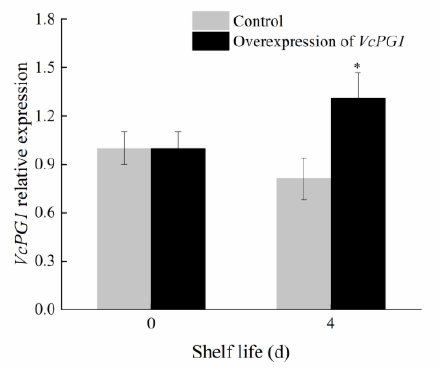
Figure 8. Changes in VcPG1 expression in VcPG1 − OE blueberries. The control fruit was injected with empty vector Agrobacterium tumefaciens. Asterisks indicate significant differences between control and overexpressing VcPG1 treatment fruit (* p < 0.05).